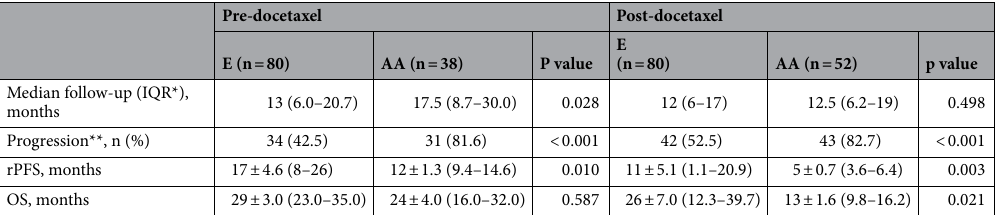
Table 2. The subgroup analysis results of the pre-docetaxel and post-docetaxel setting. IQR interquartile range, E enzalutamide, AA abiraterone acetate, rPFS radiological progression free survival, OS overall survival. *Descriptive results for continuous variables are expressed as mean and standard deviation or as median and interquartile range, depending on the normality of their distribution. **Progression rate during the follow-up period.